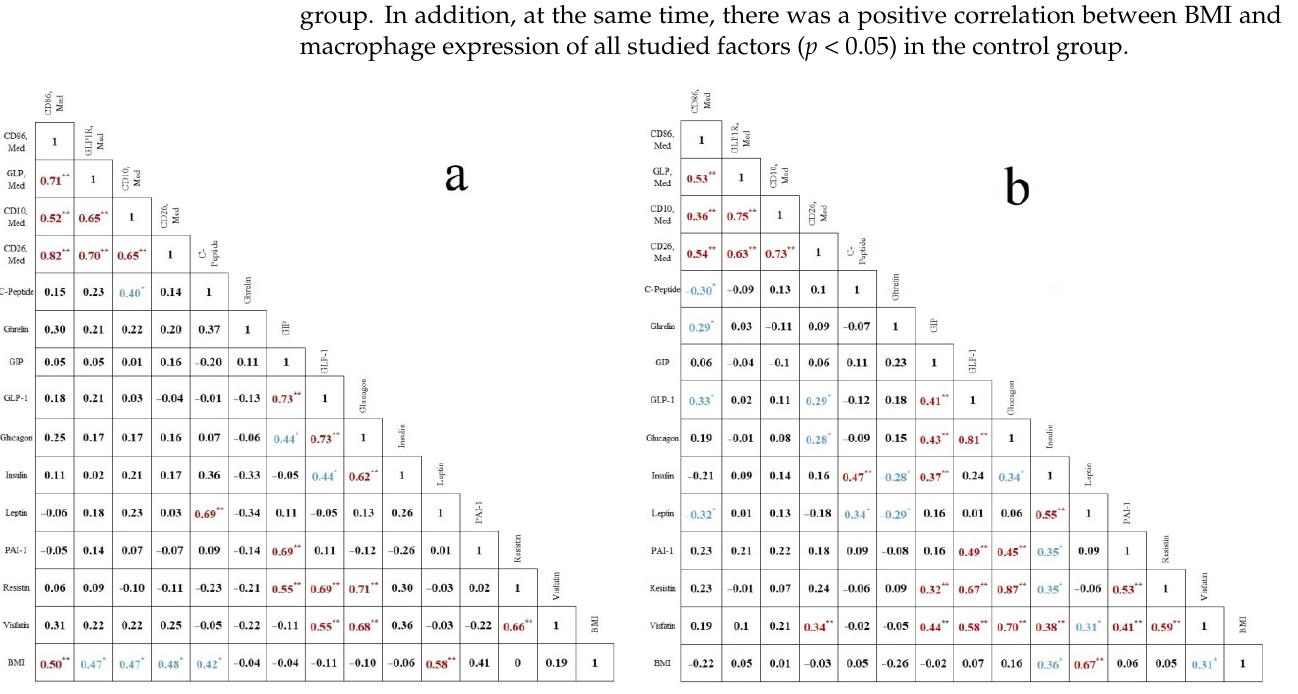
Figure 2. Correlations between energy metabolism markers (C-peptide, ghrelin, GIP, GLP-1, gluca- gon, insulin, leptin, PAI-1 (total), resistin, visfatin), GLP1R receptors, CD10 and CD26 proteases, and pro-inflammatory marker CD86. ( a ) – control group, ( b ) – endometriosis group, * — p < 0.05 (blue), pro-inflammatory marker CD86. ( a )–control group, ( b )–endometriosis group, *— p < 0.05 (blue), ** — p < 0.01 (red). **— p < 0.01